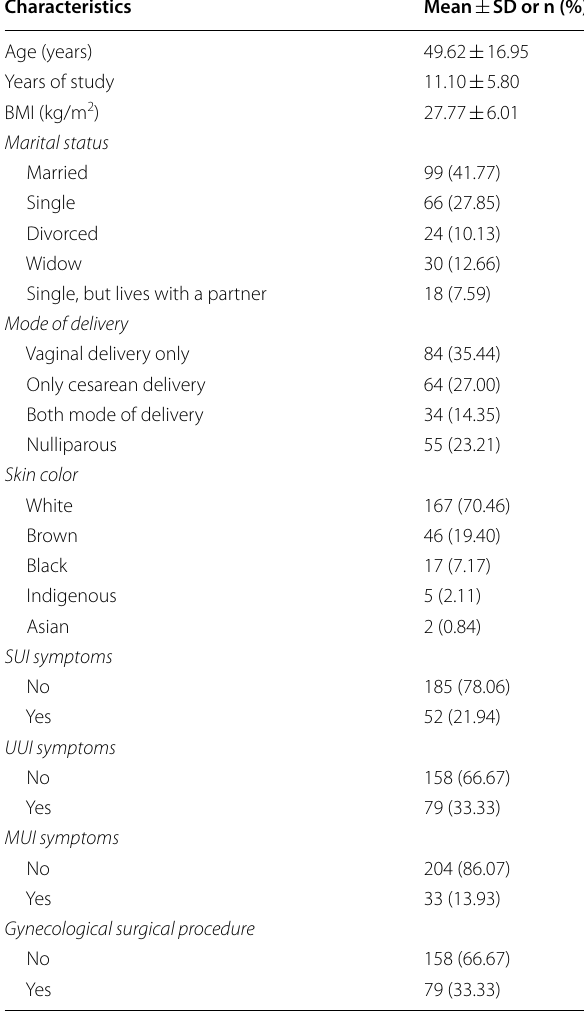
Table 1 Characterization of study participants (n